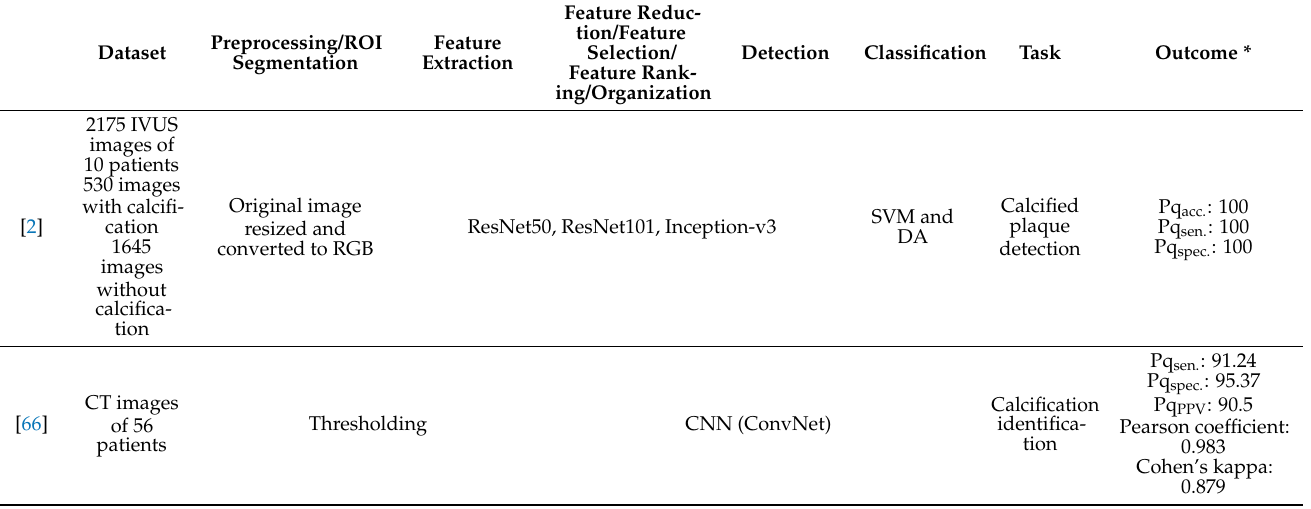
Table 2. Summary of various state-of-the-art techniques employed for plaque characterization using coronary artery scans.